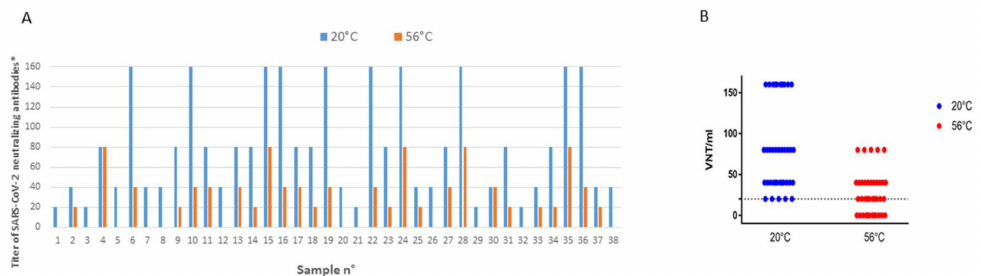
Figure 2. Impact of heat treatment at 56 ◦ C-30 min on the SARS-CoV-2 neutralization assay compared with the same sera maintained at ambient temperature (20 ◦ C). Panel ( A ), histogram representation. ( B ): point cloud representation. * Serum specimens with a titer ≥ 20 were considered